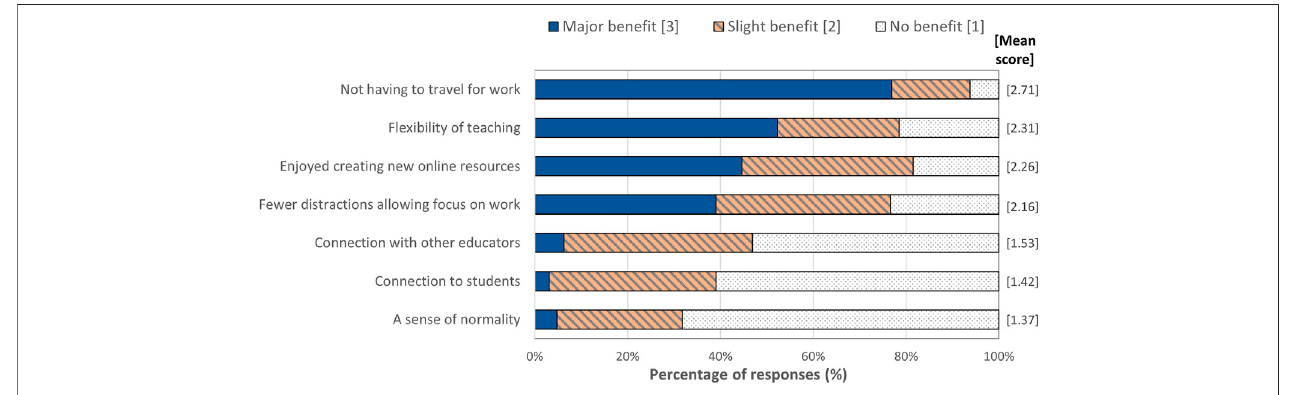
FIGURE 3 | Bene fi ts of working from home during the initial